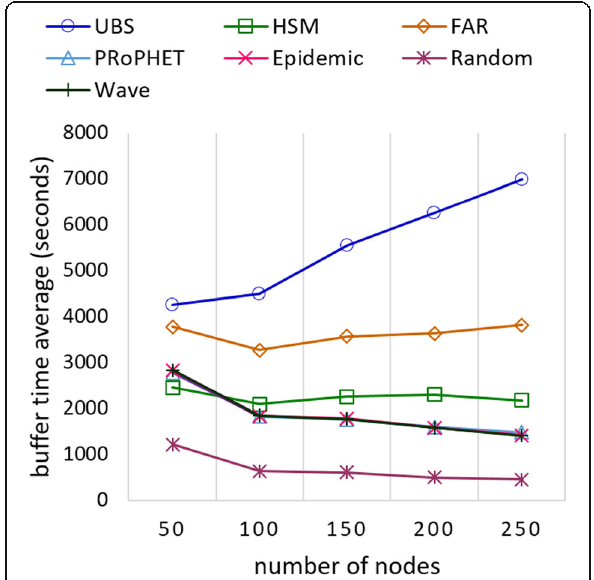
Fig. 9 The buffer time average by varying number of nodes.